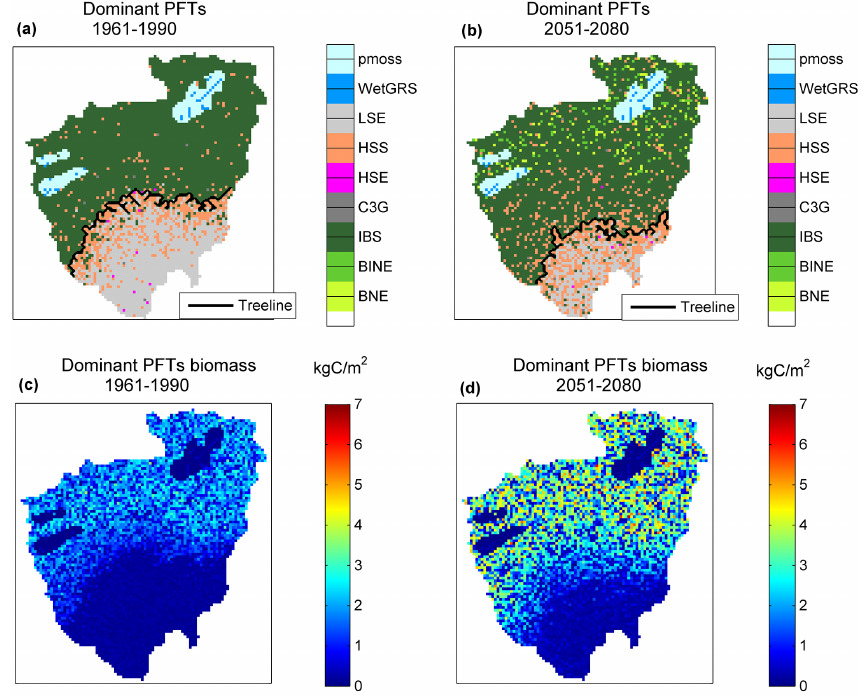
Figure 5. Dominant PFTs (a, b) and their biomass (c, d) in the study catchment, for the periods 1961–1990 (a, c) and 2051–2080 (b, d)